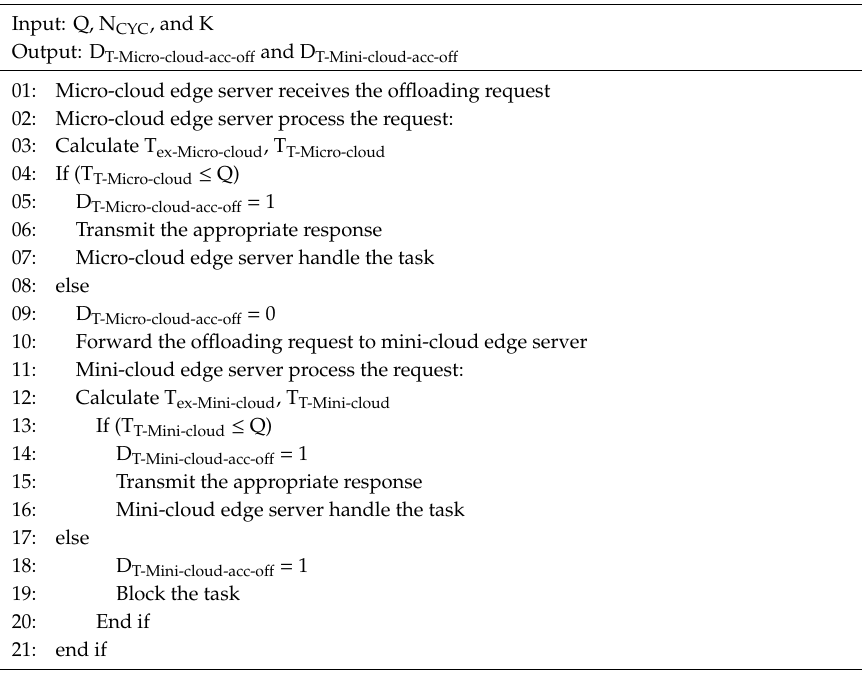
Algorithm 2. Processing o ffl oading requests at the heterogeneous edge cloud